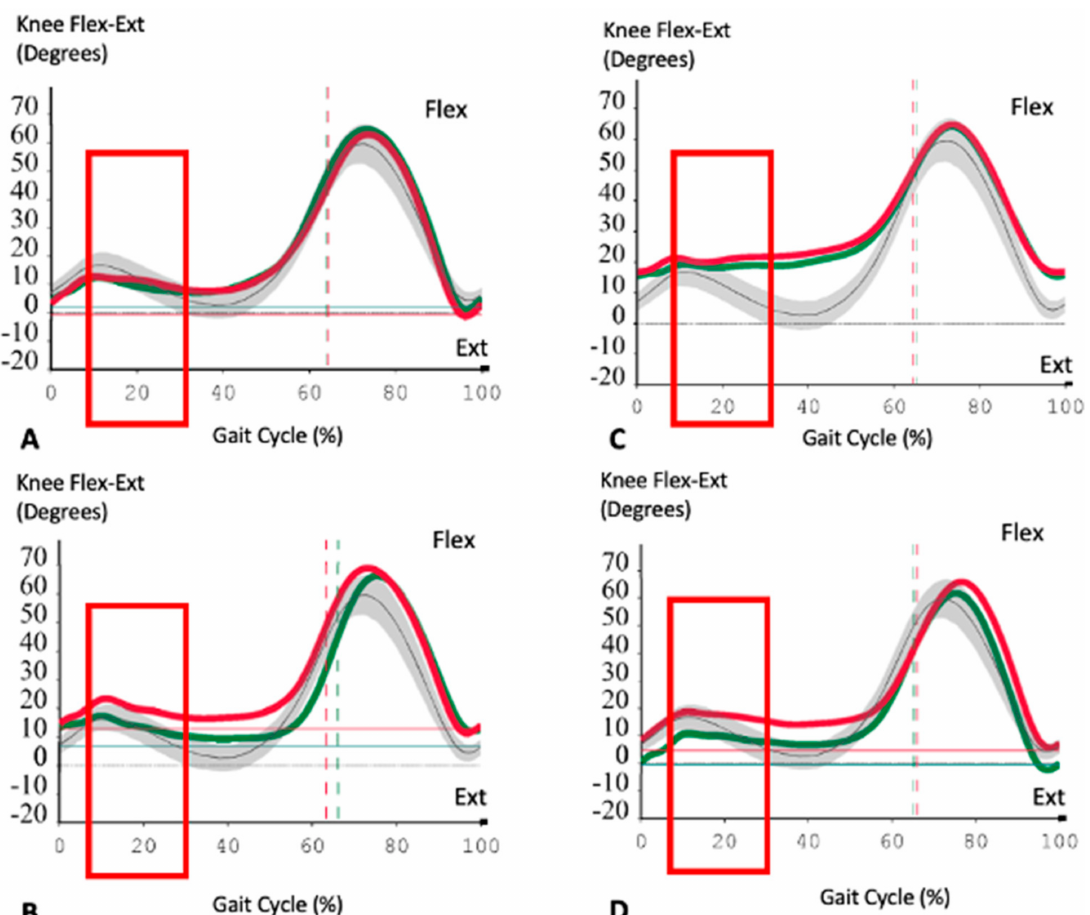
Figure 4. Descriptive kinematic analysis of 4 patients: two from Group A ( A , B ) and two from Group B ( C , D ). In ( A , B ), the operated knee is the right one (green lines) while in ( C , D ), the operated knee is the left one (red lines). Normal values are represented by grey lines and the grey area (SD). Red rectangles refer to the specific Gait Phase (MS). Minus values on the ordinate line refer to